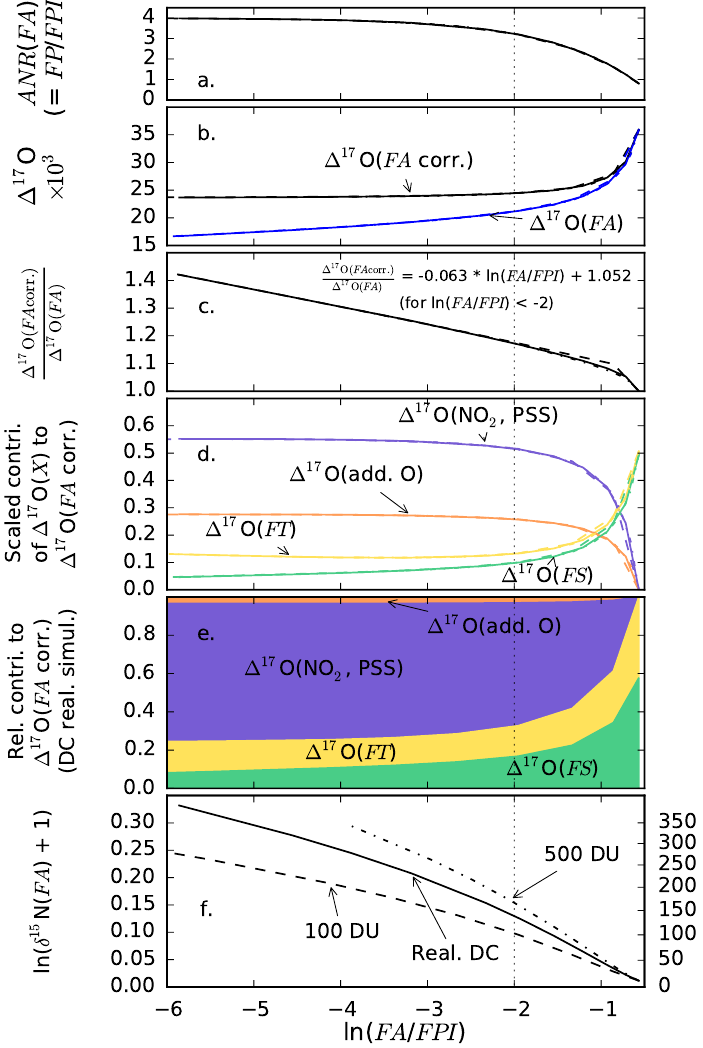
Figure 10. TRANSITS simulations of the reduction in (cid:49) 17 O(FA) under the cage recombination effects and scaled contributions to (cid:49) 17 O(FA, corr.) as a function of nitrate trapping efficiency (ln(FA / FPI)). (a) Average number of recyclings undergone by the archived nitrate (ANR(FA)), (c) (cid:49) 17 O(FA) with and without cage effect and (d) the associated (cid:49) 17 O(FA. corr.) /(cid:49) 17 O(FA) ratio, (e) the scaled contri- butions of (cid:49) 17 O(NO 2 . PSS), (cid:49) 17 O(add. O), (cid:49) 17 O(FT) and (cid:49) 17 O(FS), (f) the relative contributions to (cid:49) 17 O(FA, corr.) in the DC case ( (cid:49) 17 O(NO 2 . PSS) = 31.3‰, (cid:49) 17 O(add. O) = 3‰, (cid:49) 17 O(FT) = 30‰ and (cid:49) 17 O(FS) = 42‰), and (g) δ 15 N(FA) as a function of the ozone column. Note that for panels (a–e) , the curves for the three O 3 column case are almost superimposed. The vertical dashed line at ln(FA / FPI) = − 2 represents a threshold value below which the (cid:49) 17 O(FA, corr.) /(cid:49) 17 O(FA) ratio is linear with ln(FA /